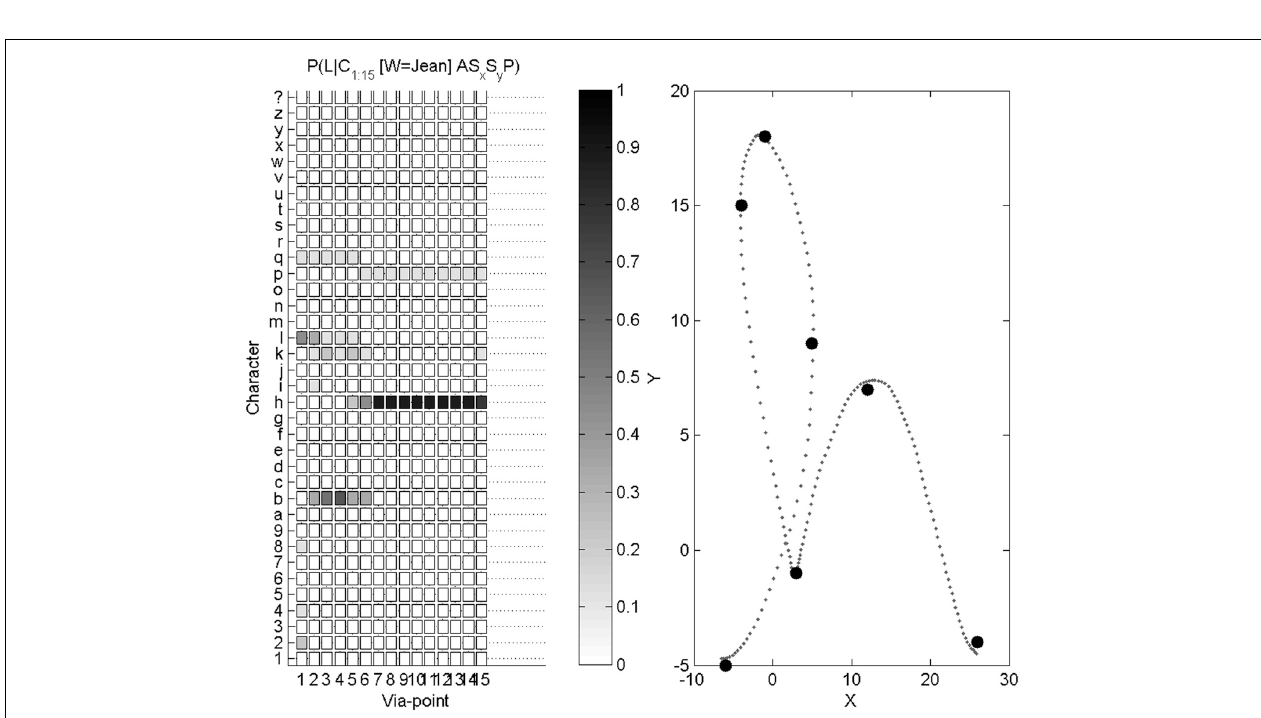
(cid:3) (cid:5) (cid:4) (cid:6) (cid:3) , C 1 (cid:2) , C 1 ˙ , C 1 ˙ (cid:3) C 1 (cid:2) , the second column is P L | L x y x y (cid:3) (cid:5) (cid:4) (cid:3) , C 1 : 15 (cid:2) , C 1 : 15 ˙ (cid:3) C 1 : 15 (cid:2) , etc., and the final column is P L x y x